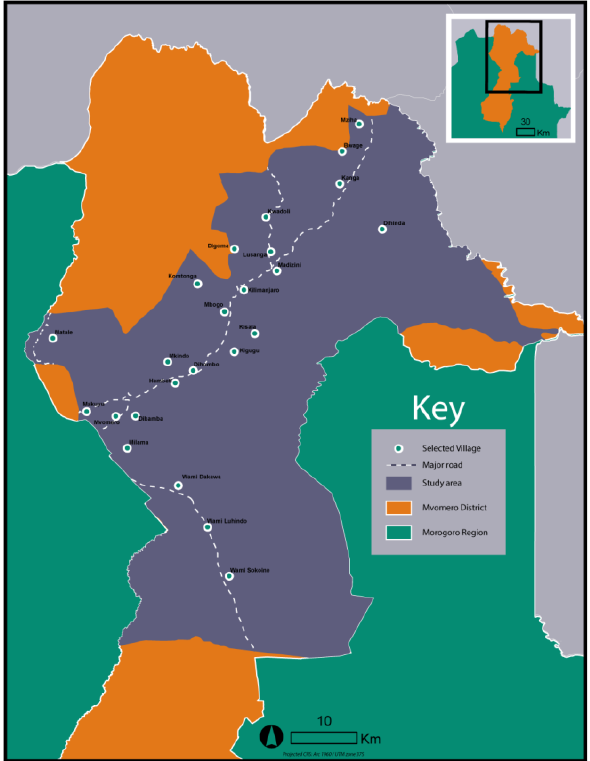
Figure 4. Map of selected